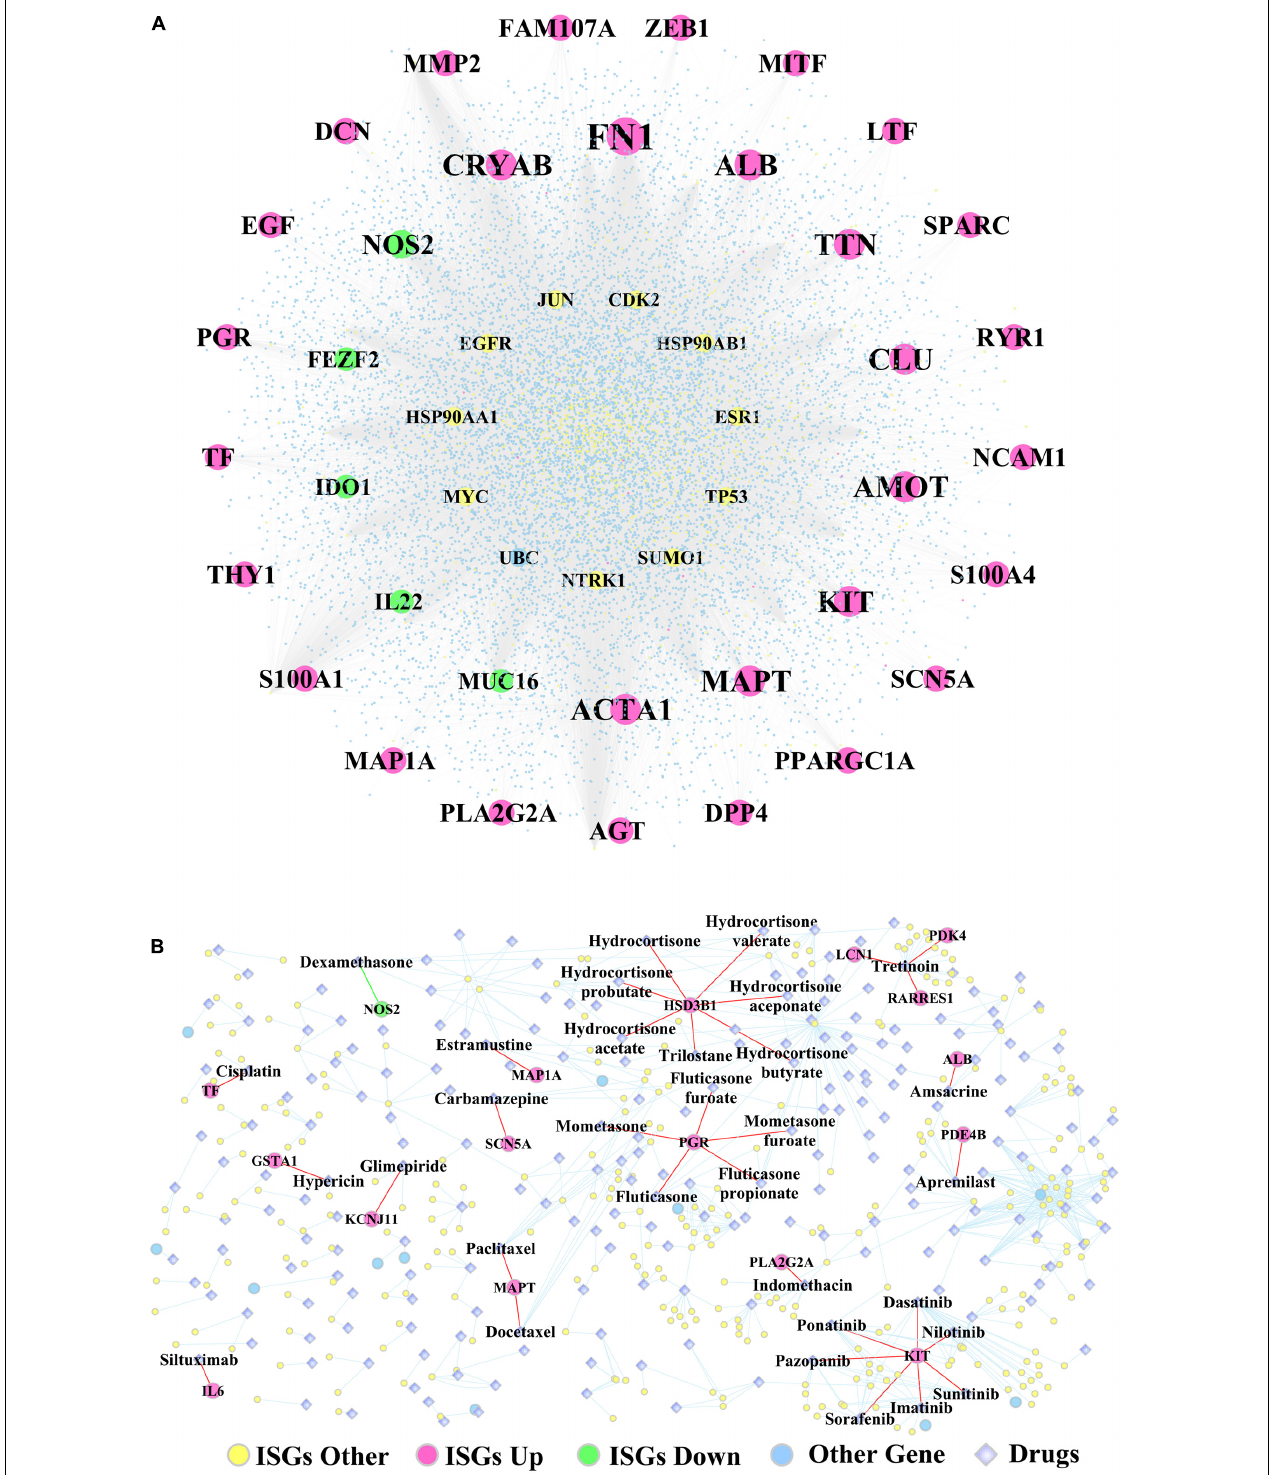
FIGURE 7 | (A) The PPI network constructed by ISGs and (B) the ISGs-target drugs regulatory network. The rose-red round nodes represent the ISGs that were DEGs upregulated between two subtypes of OSCC, the emerald round nodes represent the ISGs that were DEGs downregulated between two subtypes of OSCC, the yellow round nodes represent the ISGs that were not DEGs, the sky blue round nodes represent the genes that were not ISGs, and the diamond nodes represent the drugs targeted by ISGs.